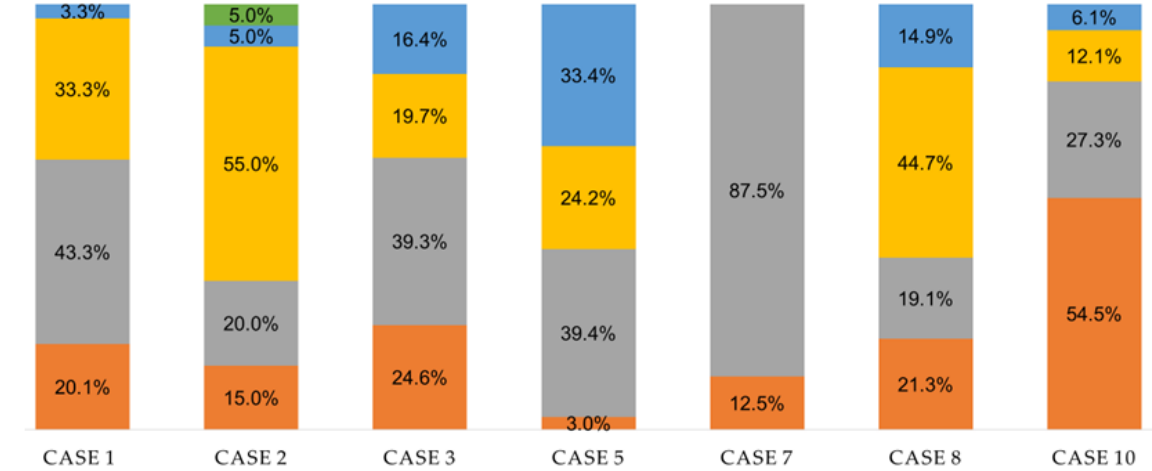
Figure 2. Percentage distribution of internal exercise loads across all sets. Perceived exertion assessed with a rating of perceived exertion (RPE) scale from 0 (extremely easy) to 10 (extremely hard) [45]. The color codes are: green—extremely hard (9–10); blue—hard (7–8); yellow—somewhat hard (5–6); grey—somewhat easy (3–4); orange—easy (1–2). Extremely easy (0) was not reported.